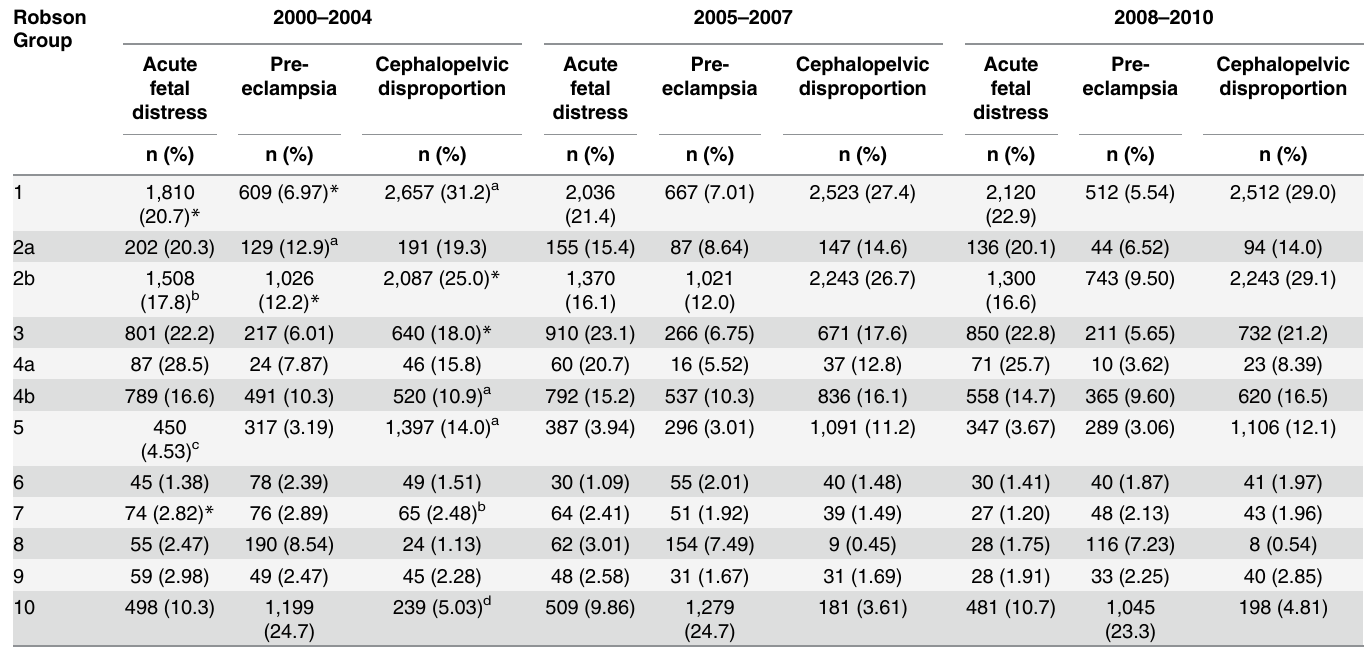
Table 8. Trends in indications for caesarean section in the relevant categories of women in the Robson classification in Peru, 2000 – 2010. Robson